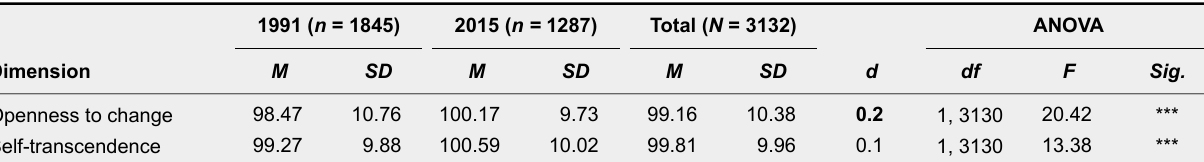
Overall Change in the Two Value Dimensions Between 1991 and 2015 Dimension Sig.FdfSDMSDMSDM Note. For value changes that met the DS criterion ( p < .05 and d ≤ -0.2 or d ≥ 0.2), d s are printed in underlined bold to indicate an increase, and in mere bold to indicate a